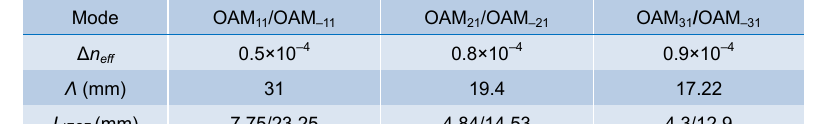
Table 1 | Structural parameters of IECFs for the generation of OAM modes